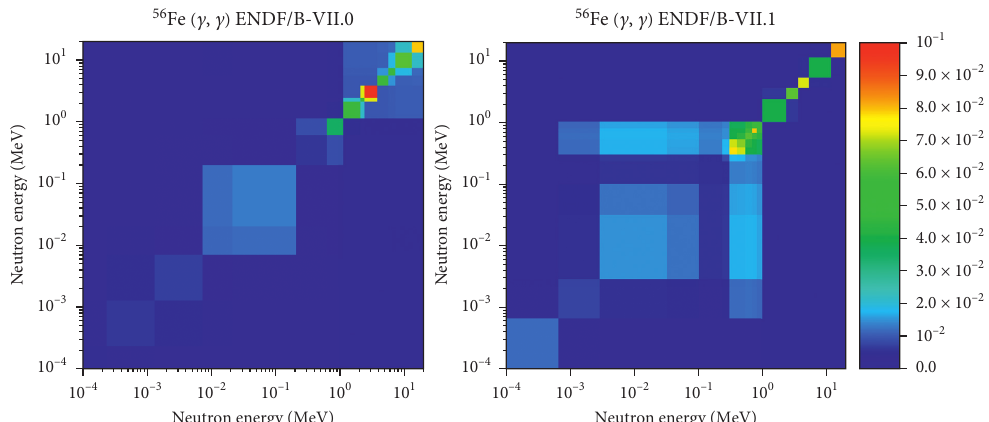
Figure 24: 56 Fe (capture, capture) 44-g and 55-g covariance